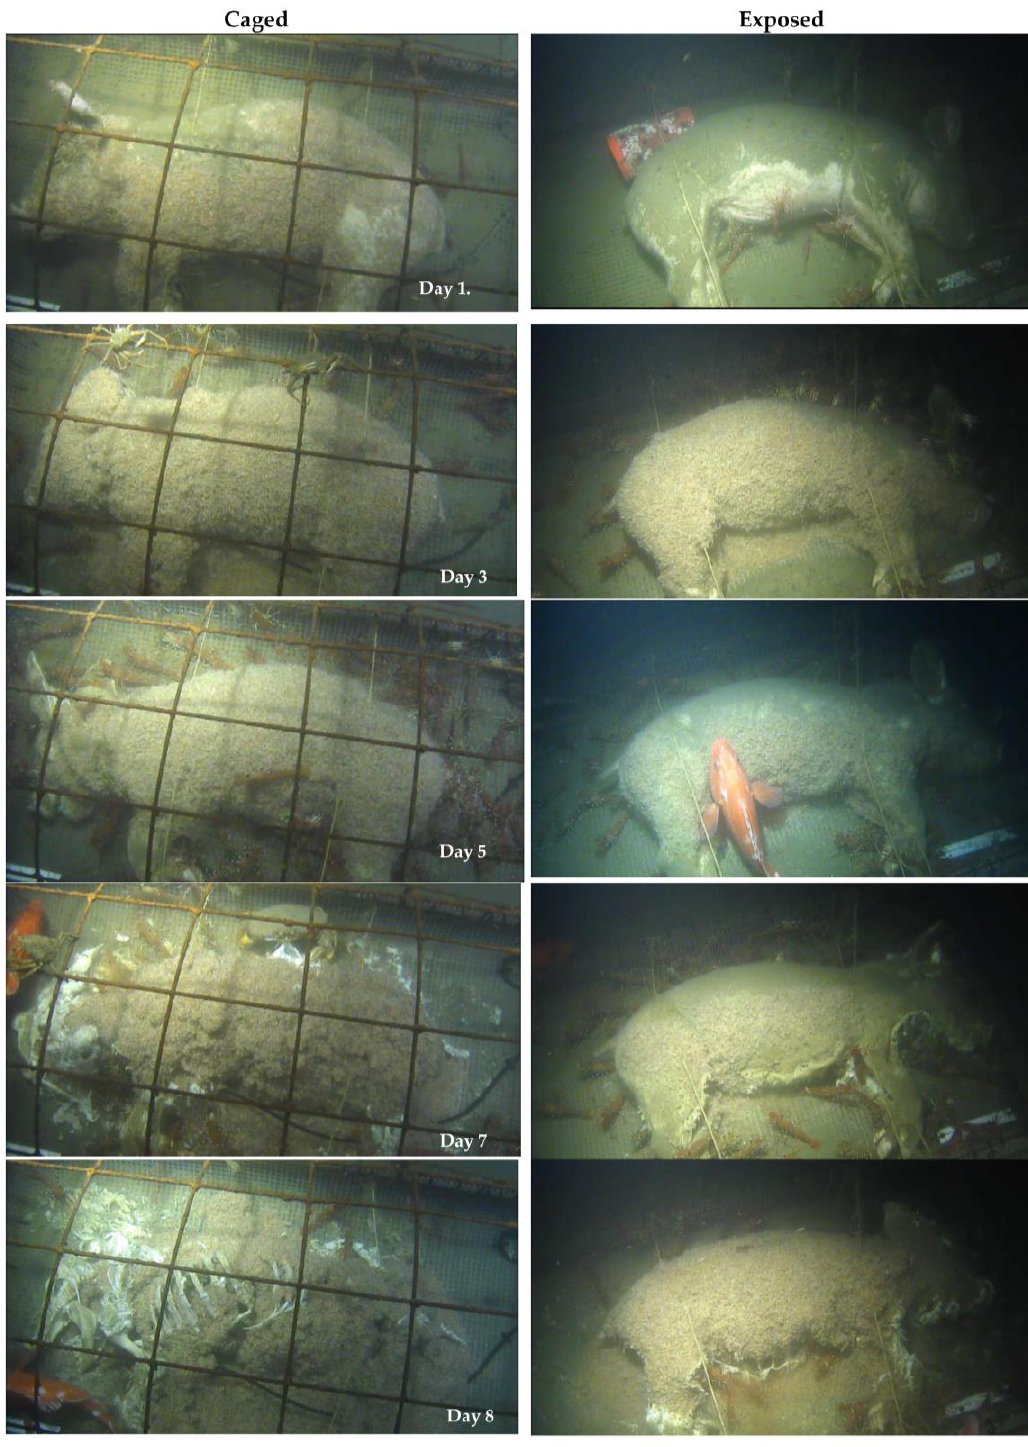
Figure 2. Faunal scavenging of caged and exposed carcasses in spring at 170 m in the Strait of Georgia (Ocean Network Canada’s VENUS observatory).